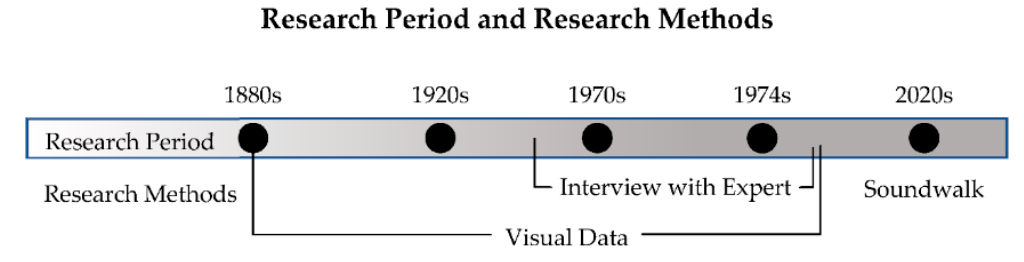
Figure 2. Research Period and Research Methods.